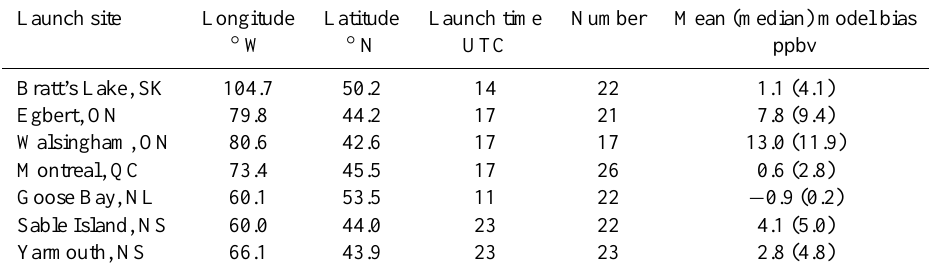
Table 1. Location of ozonesonde launch sites during the BORTAS-A measurement campaign, the typical sonde launch time at each site in hours UTC, and the number of ozonesondes launched from each site between 12 July and 4 August 2010. The right-hand column reports the mean and median of the model minus ozonesonde bias in the troposphere (from the surface to 10 km). The distribution of the launch sites across Canada is shown in Fig.